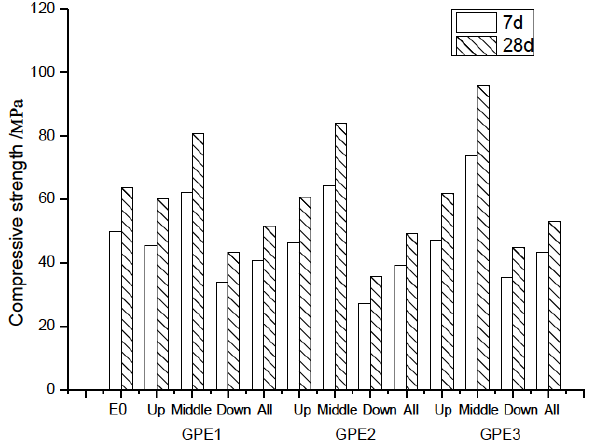
Figure 2: Compressive strength of GPE1 ~